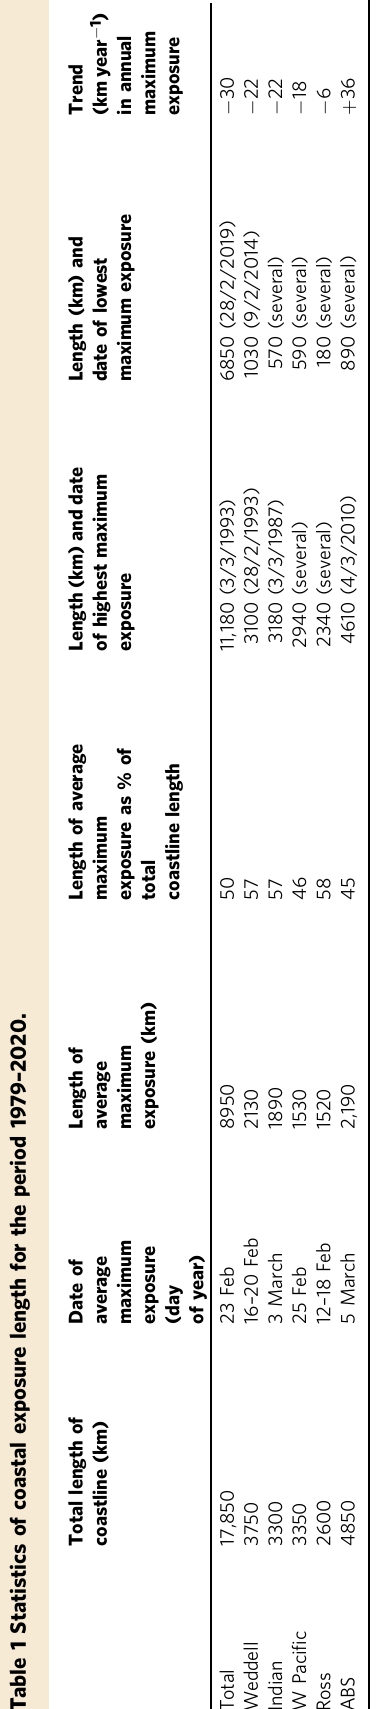
Table 2 Sector cross-correlations of annual